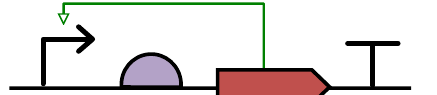
Figure 35: Promoter stimulated by the CDS that it regulates.